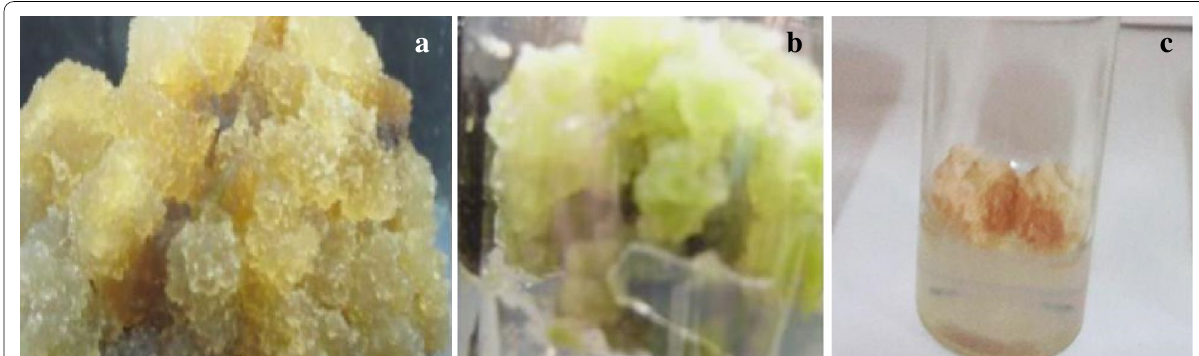
Fig. 2 Callus obtained from Gazania rigens explants after 4 weeks of incubation: a callus from stem explant with 1.5 mg/L 2,4‑D, b callus from leaf explant with 1.0 mg/L 2,4‑D, and c callus from control treatment (2,4‑D‑free)